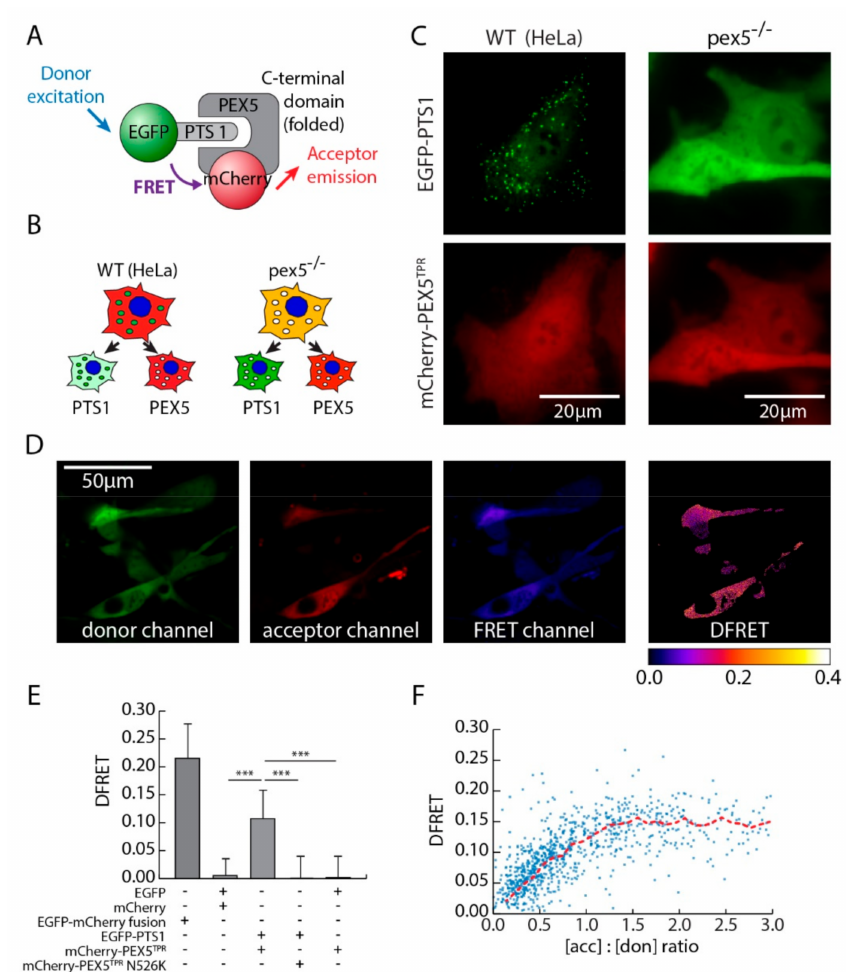
Figure 1. Förster-resonance-energy-transfer (FRET) measurement of the PEX5-PTS1 interaction by fluorescence microscopy. ( A ) Scheme of the interaction and FRET between PTS1-tagged EGFP and the TPR-domain of PEX5 (grey) tagged by mCherry; ( B , C ) cytosolic interaction between receptor and targetingsignalsinthecytosolofcellslackingPEX5: uponco-expressioninHeLacellsmCherry-PEX5 TPR (red) is cytosolic, whereas EGFP-PTS1 (green) is peroxisomal (left side), but in murine pex5 − / − cells both proteins reside in the cytosol (right side); ( D ) microscopy-based 3-filter-FRET experiment using pex5 − / − cells transiently expressing mCherry-PEX5 TPR and EGFP-PTS1 (Hs55): fluorescence intensity is depicted from left to right in the donor channel, the acceptor channel and the FRET channel (see Materials and Methods for channel definitions), whereas DFRET intensity is depicted by the color-code. ( E ) Quantification of FRET measurements from cells expressing either mCherry-PEX5 TPR + EGFP-PTS1 (Hs55) or the positive control (mCherry-EGFP), the negative control (EGFP + mCherry), and one of two controls ablating either the PTS1 binding ability of PEX5 TPR (PEX5 TPR -N526K) or by removing the PTS1 of EGFP (EGFP) using the microscopy based measurement (from left to right: n = 648, 129, 537, 190, 150). ( F ) Plotting DFRET values of cells obtained for the interaction between mCherry-PEX5 TPR and EGFP-PTS1 against the acceptor to donor ratio ([acc]:[don]) distributes the data similar to a saturation curve ( n = 537), which is visualized by connecting averages of bins of 0.1 units (red line). Statistics: Kruskal-Wallis test was used with subsequent pairwise testing, *** p < 0.001; Ex excitation, Em emission. Description: bars and whiskers in ( E ) depict mean ±